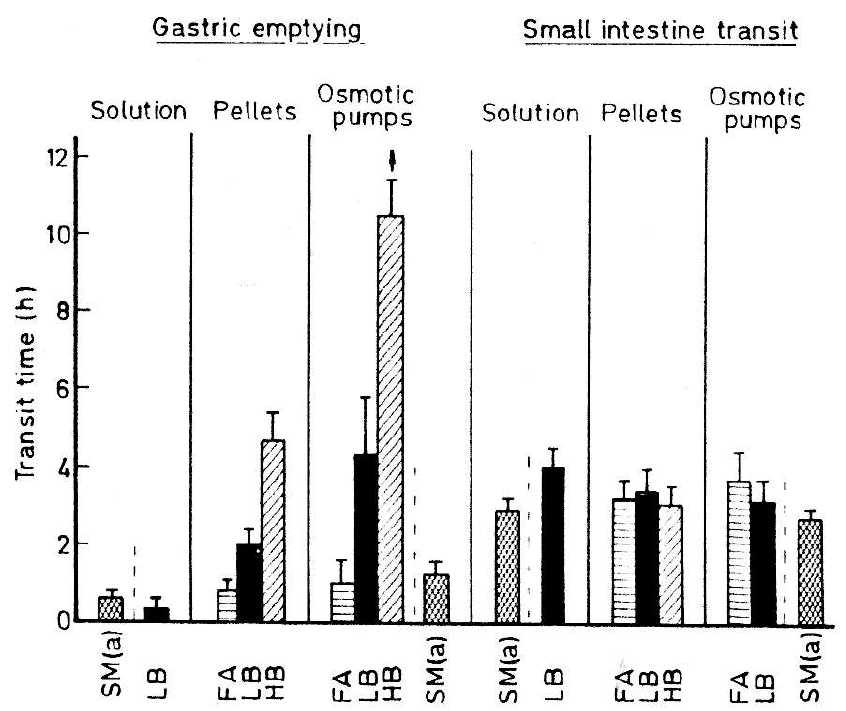
Figure 2. GI transit of dosage forms. Reprinted with permission from Ref. [27]. 1985, Elsevier. LB: Light Breakfast (1500 kJ); HB: Heavy Breakfast (3600 kJ); FA: Fasted; SM: Standard Meal (solution and solid fiber 1 – 5 mm in length).